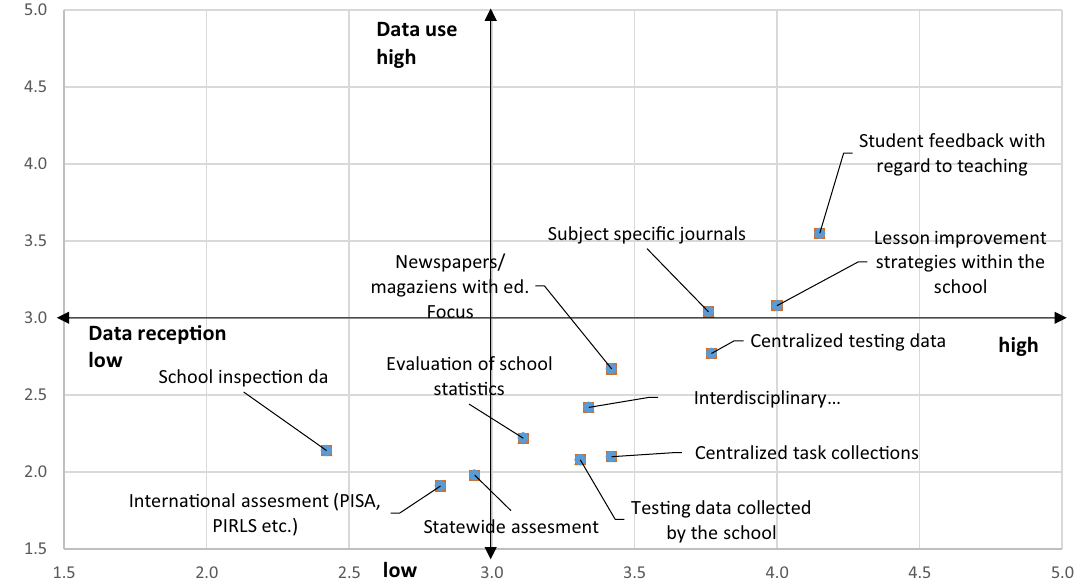
Fig. 2 Reception and use of different evidence sources by teachers ( N = 1230). This fi gure depicts the reception and use of different evidence sources by teachers, drawing on fi ndings from van Ackeren et al.,